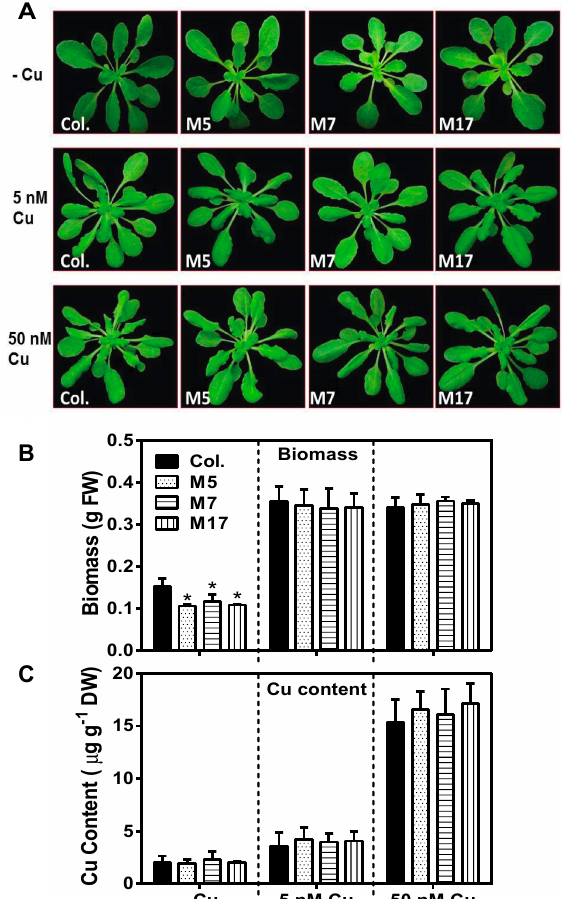
Figure 3. E ff ect of Cu-microRNA target mimicry on plant growth in hydroponics. ( A ) Representative images of 5-week-old WT (Col.); M5, M7, and M17 are All3-Cu miRNA mimicry lines. Plants were grown on 1 / 10th strength Hoagland solution containing 0, 5, or 50 nM CuSO 4 . ( B ) Fresh weight and ( C ) Cu content ( µ g g − 1 DW) of 5-week grown plants. Values are given as averages ± SD ( n = 6). * indicate significant di ff erences ( p < 0.05, Student’s t -test).